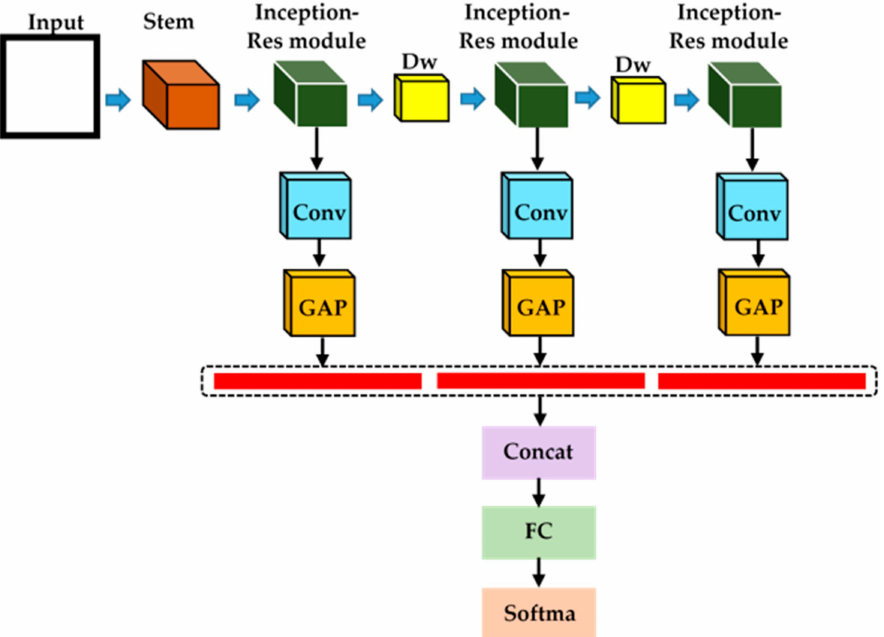
Figure 2. The proposed model is based on the Inception-ResNet module with multiscale feature extraction and concatenation for COVID-19